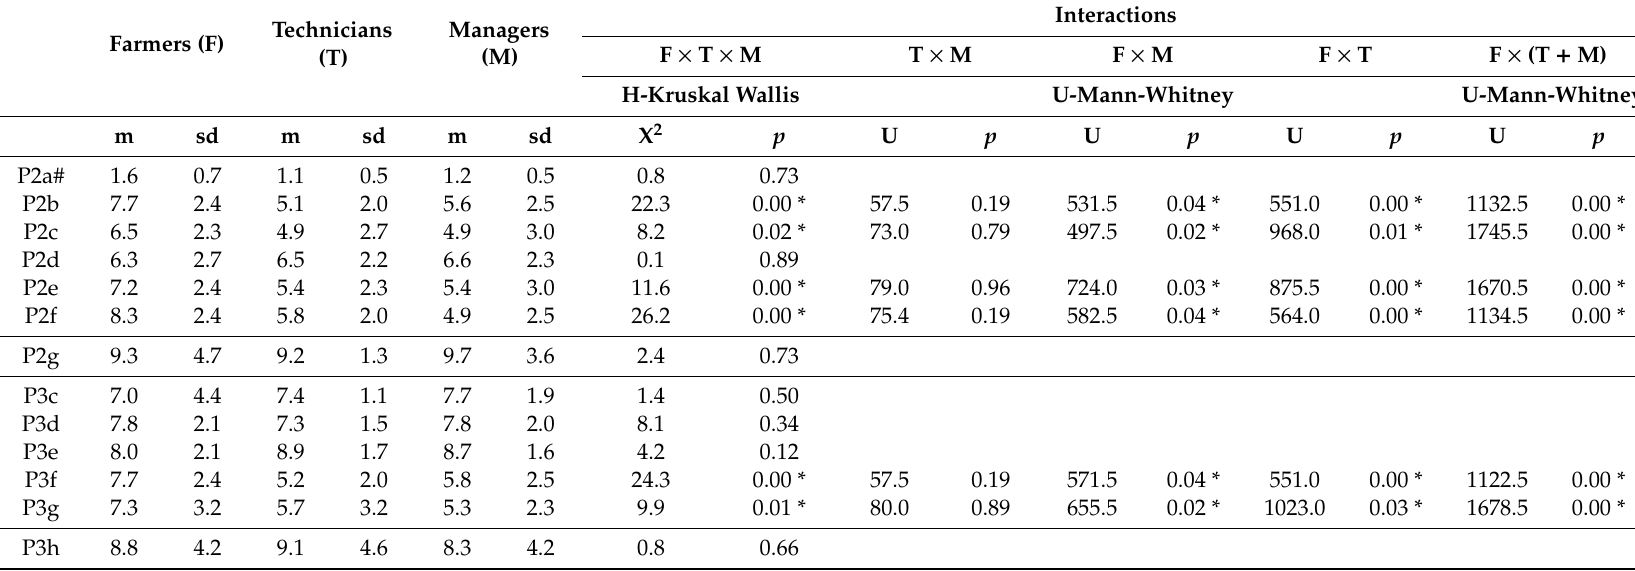
Table 4. Analysis of the quantitative variables of the